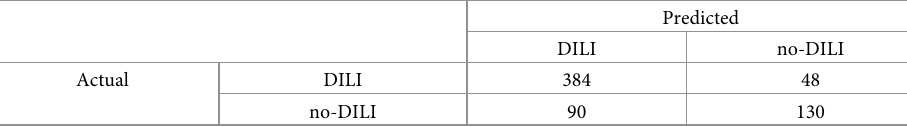
Table 1. Confusion matrix of the final tree mode.